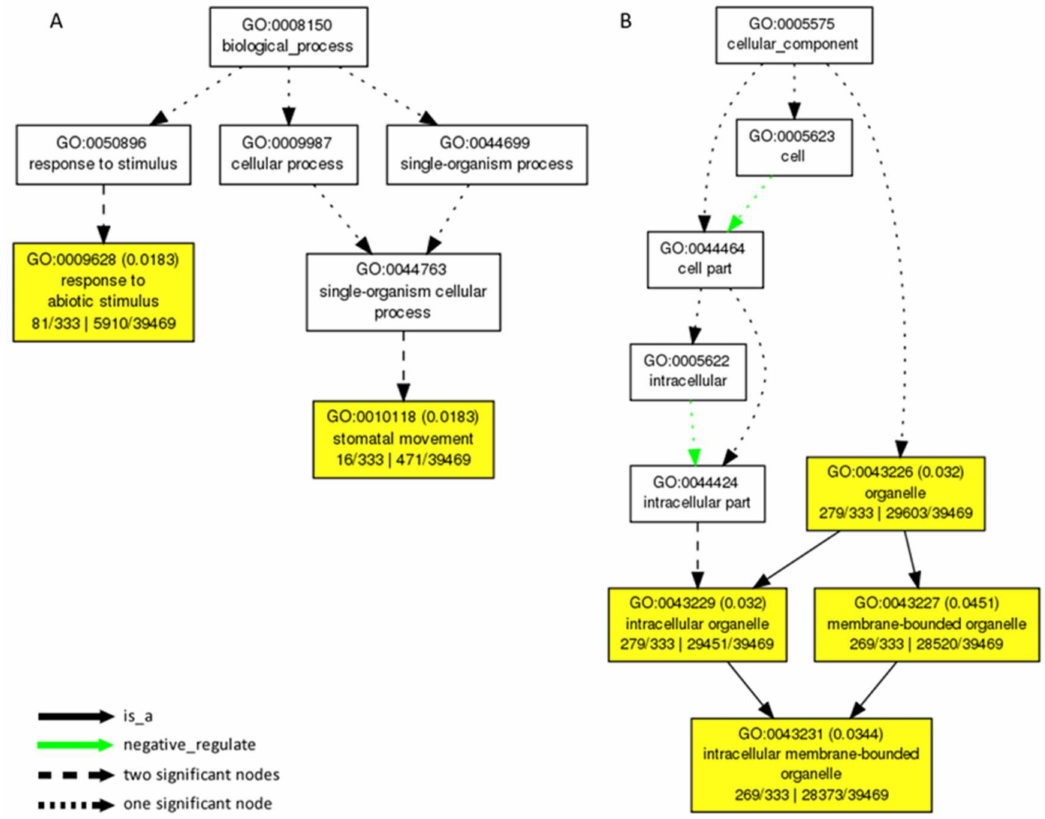
Figure 5. The significantly ( p < 0.05) enriched GO terms for genes identified in GWAS under low-P condition with a significance threshold of 4. ( A ) Significant GO terms in the biological process. ( B ) Significant GO terms in the cellular component. The yellow rectangles represent significant GO terms ( p < 0.05), and the green lines represent negative